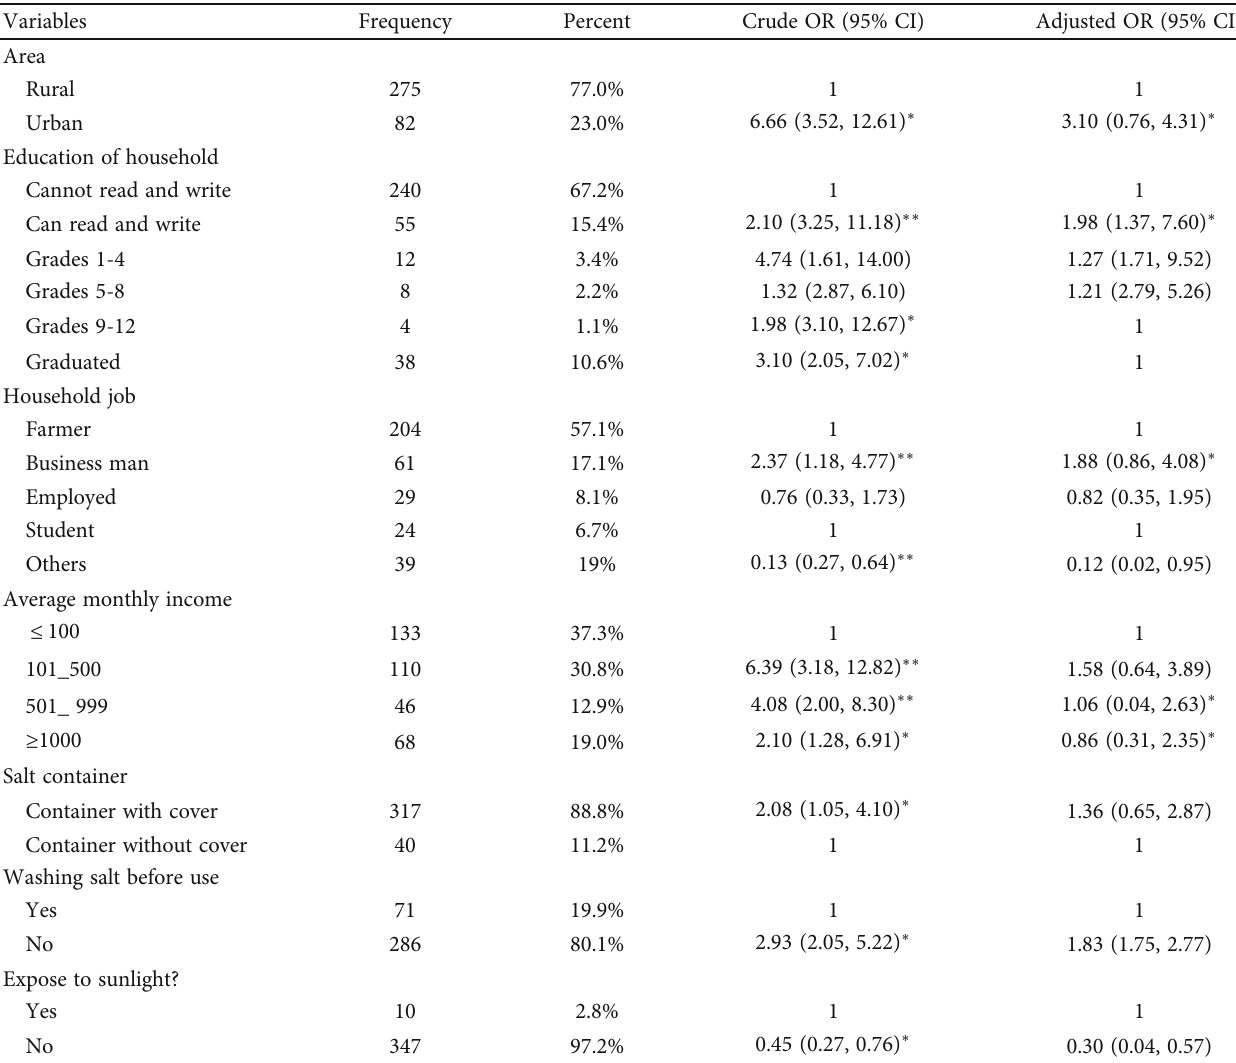
Table 5: Factors associated with knowledge of iodized salt in the study